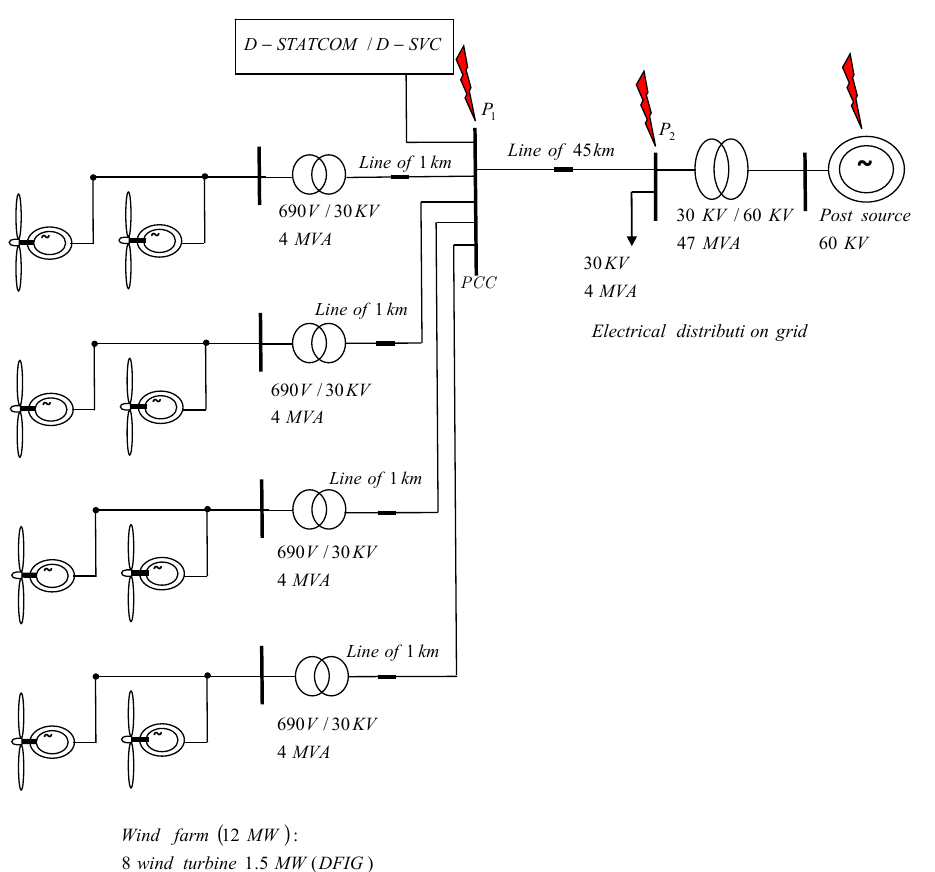
Figure 11. Structure of the studied system based on a wind farm and a distributed-flexible AC transmission system (D-FACTS) connected to the Algerian distribution grid.